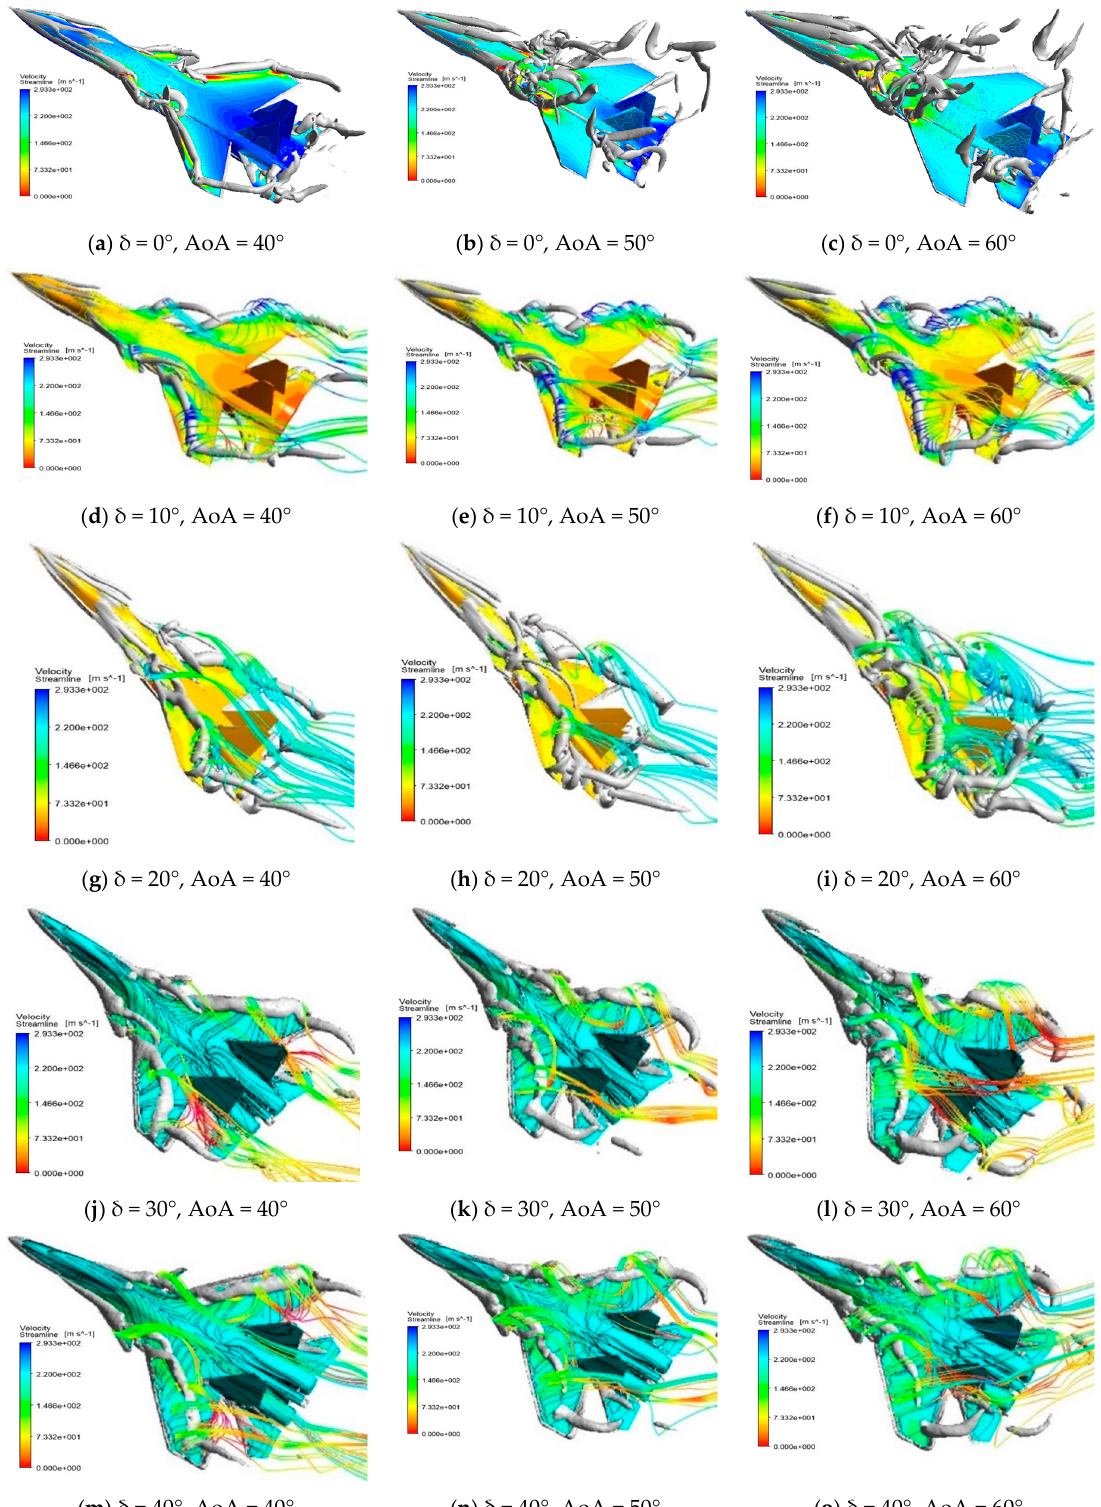
Figure 4. Vortex core, wall shear streamline, and velocity pathline visualization at canard deflection angle ( δ ) = 0°, 10°, 20°, 30°, and 40°, at various AoA 40°, 50°, and 60°.